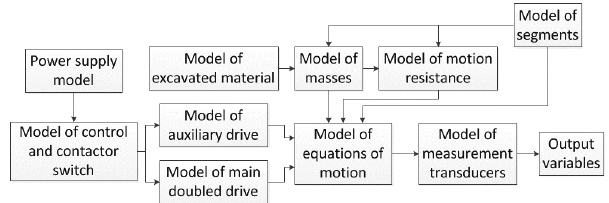
Fig. 2. The scheme of the assumed model of a scraper conveyor